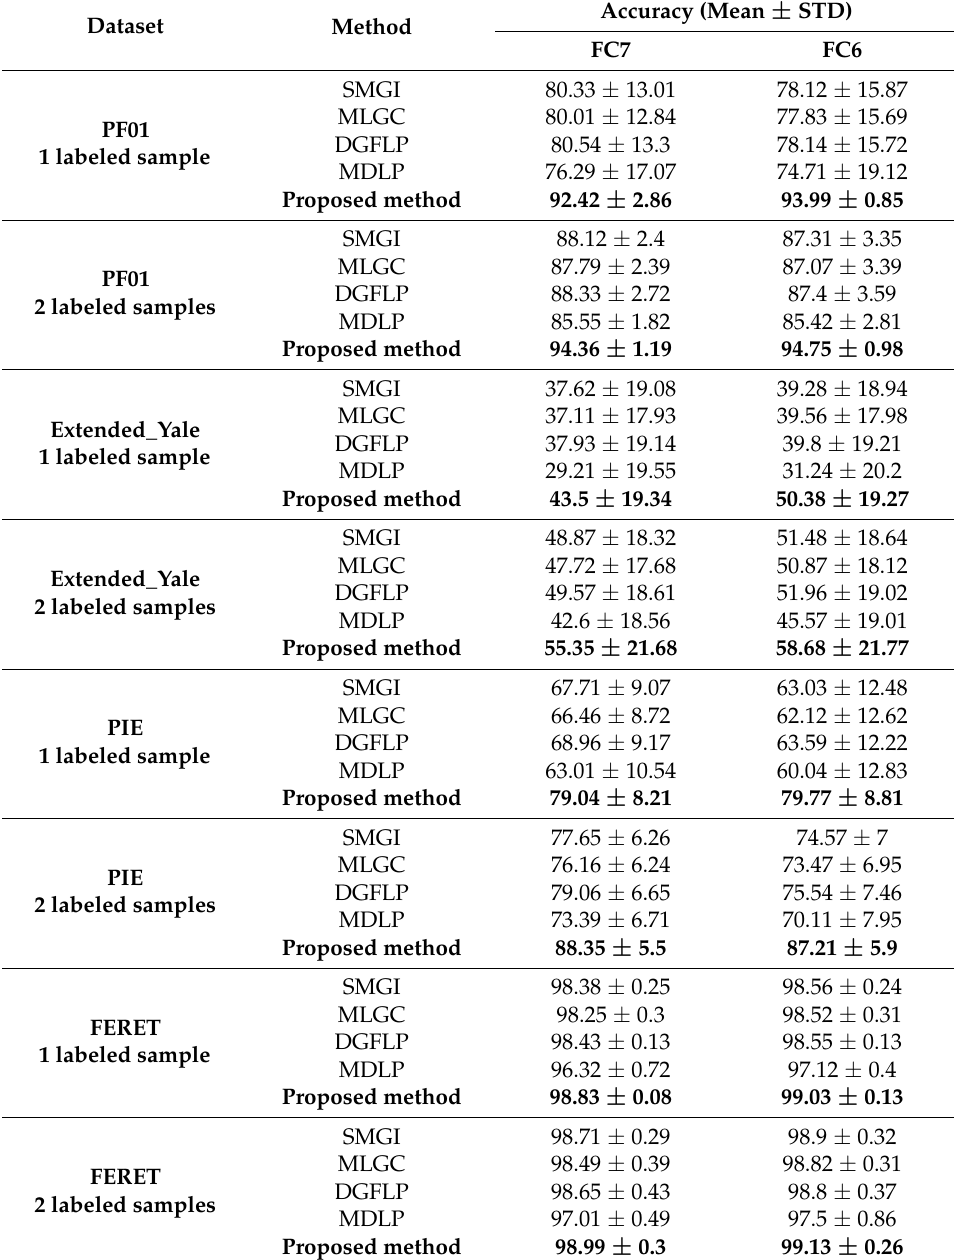
Table 4. Mean accuracy and standard deviation of the accuracy of the proposed method compared with other methods based on VGG Face-FC7 and VGG Face-FC6 features. DGFLP = dynamic graph fusion label propagation; SMGI = sparse multiple graph integration; MLGC = multi-view local and global consistency; MDLP = multi-modality dynamic label